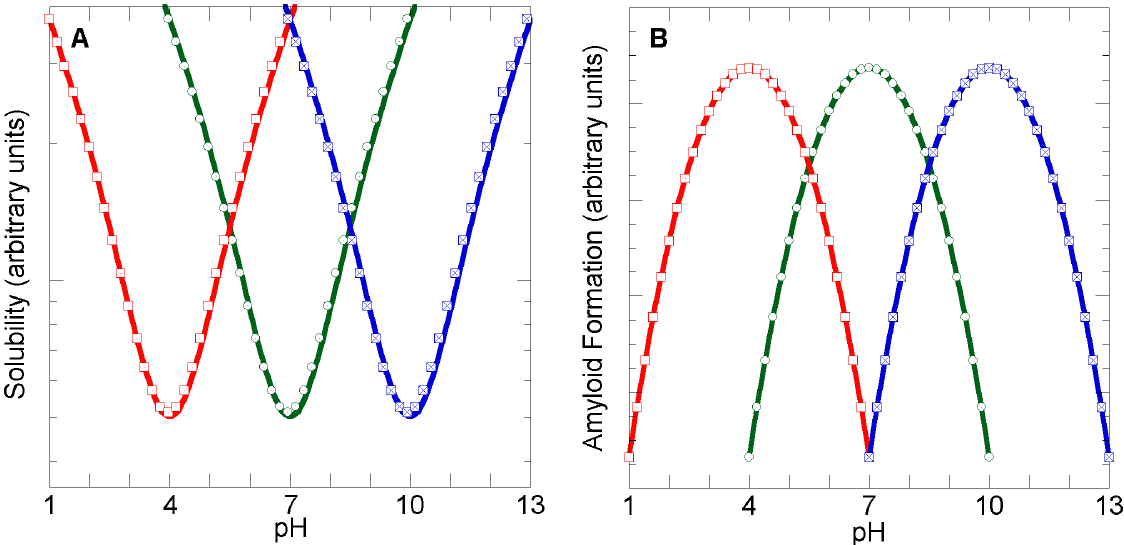
Fig 1. Protein aggregation and amyloid formation are favored by a low net charge. Idealized dependence of the solubility ( A ) or amyloid formation ( B ) by proteins with isoelectric points at pH 4 (red), 7 (green), and 10 (blue). Adapted from Fig 15 – 2 of [6] and Fig 1 of [7] (panel A ) and Fig 1 of [8] (panel B ). Please see S1 Data, columns A – E and columns G – J for the underlying data of panels A and B,